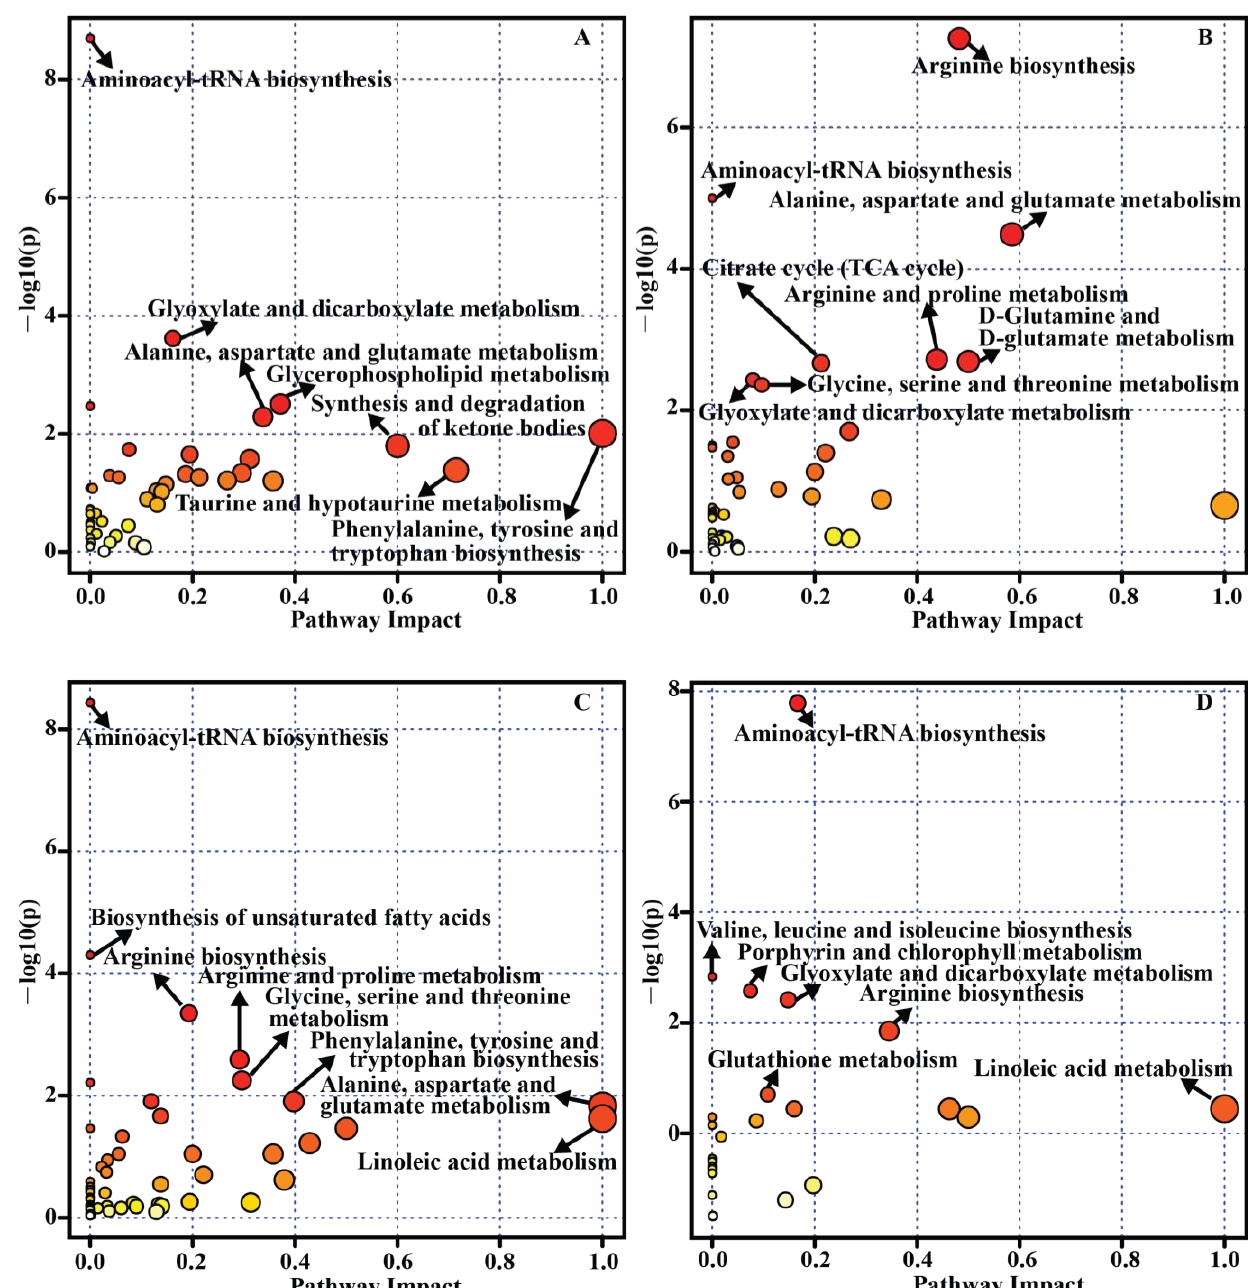
Figure 3. Pathway analysis for differential metabolites/biomarkers of retinal diseases across samples and studies. ( A ) AMD, ( B ) DR, ( C ) glaucoma, and ( D ) ROP.